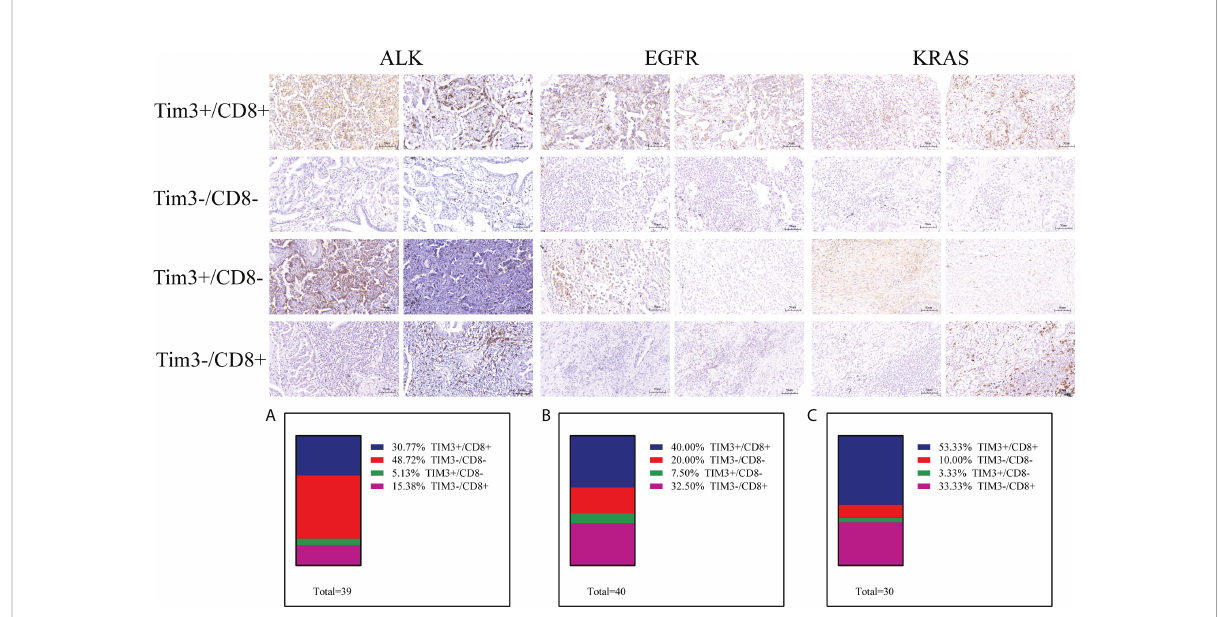
FIGURE 5 Differential proportion of TIM3+/CD8+, TIM3-/CD8-, TIM3+/CD8-and PTIM3-/CD8+ in ALK-positive (A) , EGFR-positive (B) and KRAS-positive (C) NSCLC. Low (-) and High (+) expression.